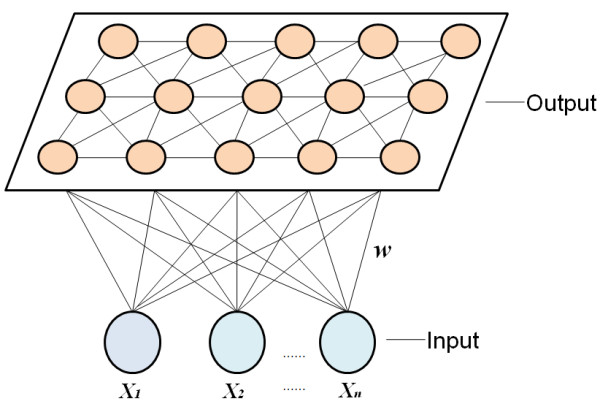
Structure of SOM.